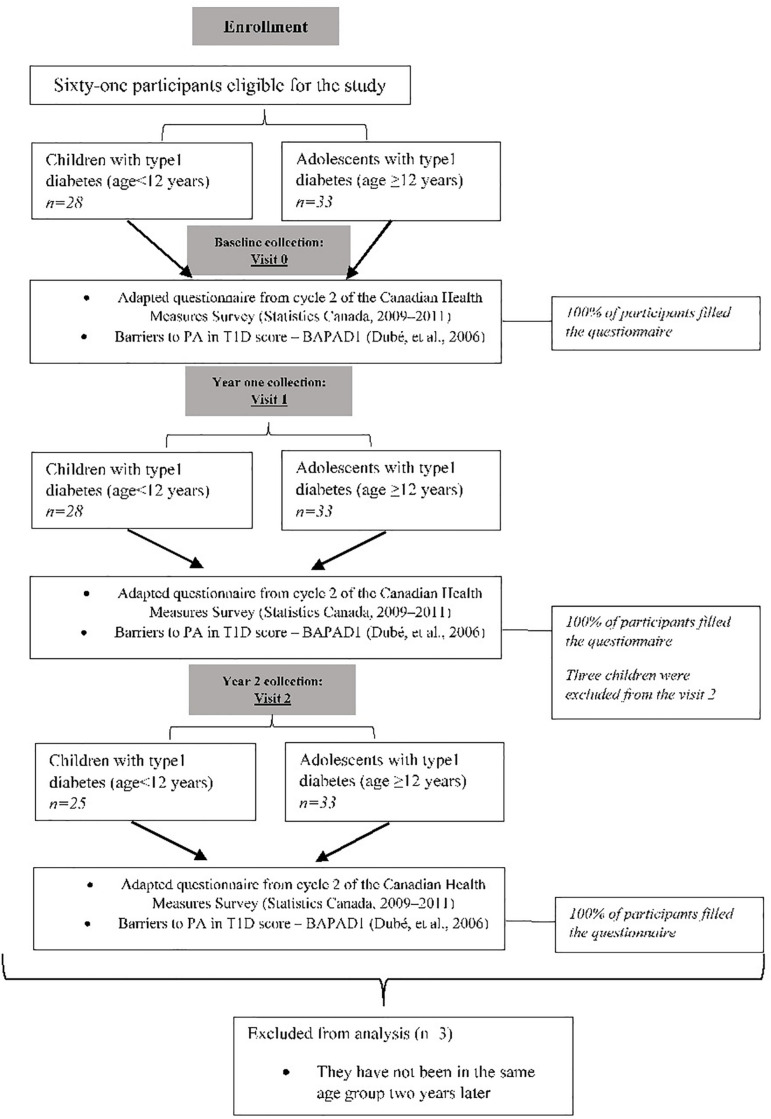
Flow chart of study design and participants’ enrollment.